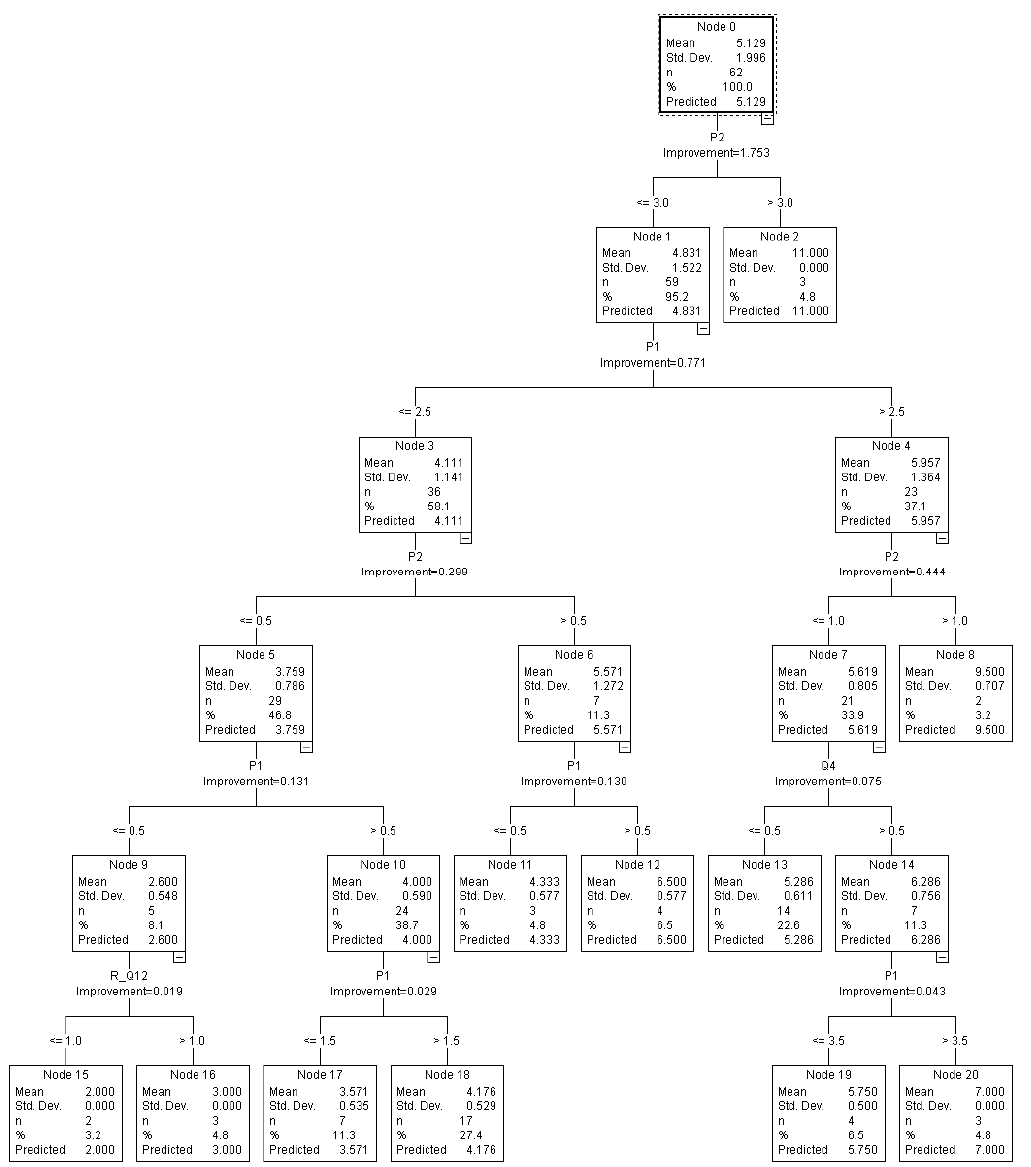
Figure 4. Decision tree model M3 for Score and G3 predictor group.